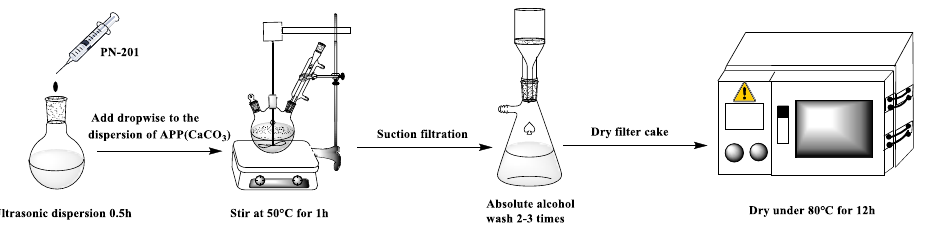
Figure 3. Mechanism of modified APP and CaCO 3.